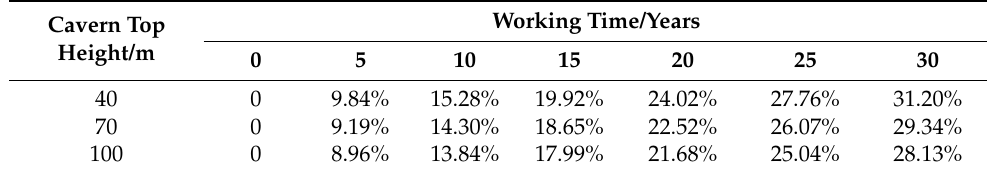
Table 2. Volume shrinkage of the cavern with different upper shapes at different working times under the internal gas pressure of 14 MPa.